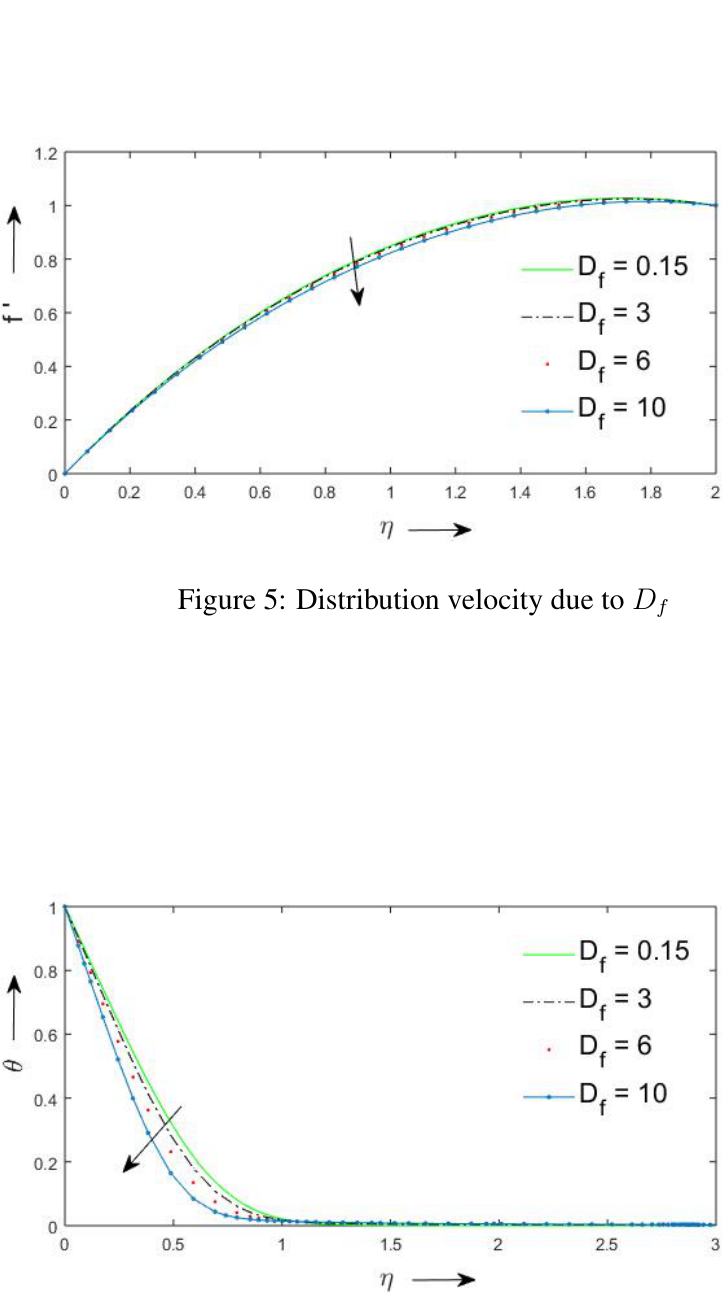
Figure 6: Distribution temperature due to D